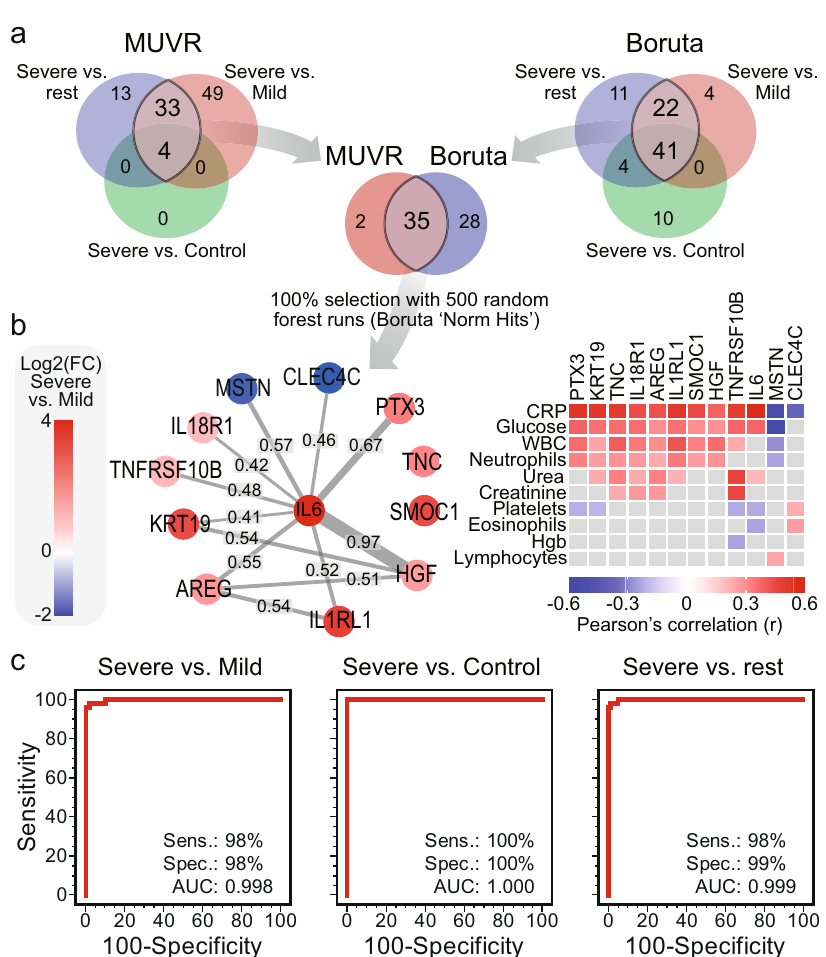
Fig. 5 A signature of 12 plasma proteins can differentiate COVID-19 cases with severe complications versus mild symptoms. a Two variable (feature) selection algorithms were used to select the most robust proteins to differentiate severe cases from mild cases and controls; MUVR (multivariate modeling with minimally biased variable selection in R) and Boruta (a wrapper algorithm for all relevant feature selection and feature importance with random selection runs). Proteins that were shared in the differentiation between patients with severe COVID-19 from the rest of the cohort, and speci fi cally from mild-moderate cases, using MUVR and Boruta were overlapped to select 35 proteins, of which 12 proteins were selected at 100% from 500 random forest runs (Boruta ‘ Norm Hits ’ ). b Network analysis for the 12 selected proteins showing the STRING-db con fi dence score. The heatmap summarizes the signi fi cant Pearson ’ s correlation coef fi cients between the 12 selected proteins and clinical blood markers and blood cell counts. c ROC curves based on the 12 DEPs, which were used to calculate the COVID-19 molecular severity score to evaluate the sensitivity, speci fi city, and the area under the ROC curves (AUC) for differentiating severe COVID-19 cases from mild cases, controls, or both. All ROC curve analyses were signi fi cant ( p < 0.0001 from AUC of 0.5, DeLong et al. method 70